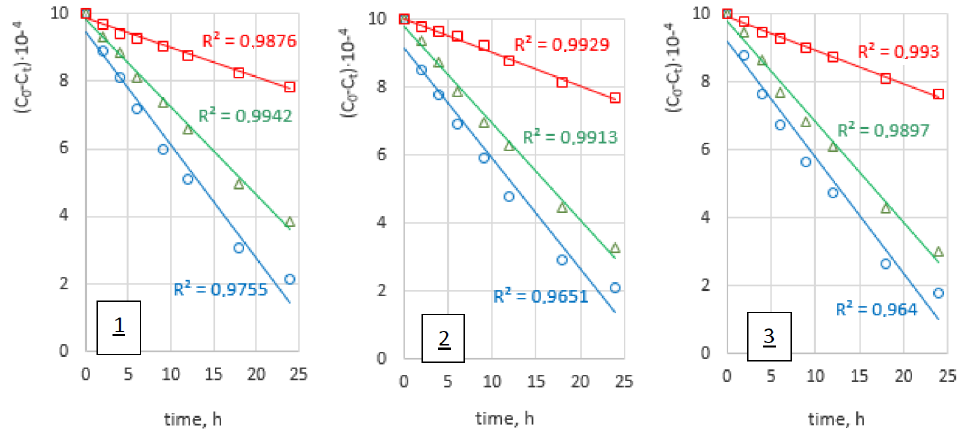
Figure 7. Relation of (C o – C t ) plotted vs. time for ( ) Zn(II), ( ) Cd(II), and ( ) Pb(II) ions transport